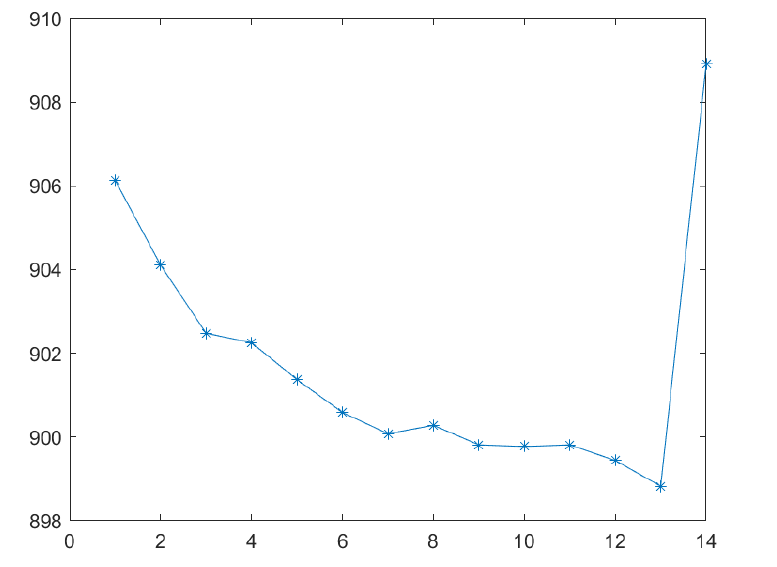
Figure 9. One of the characteristic trends of the addresses